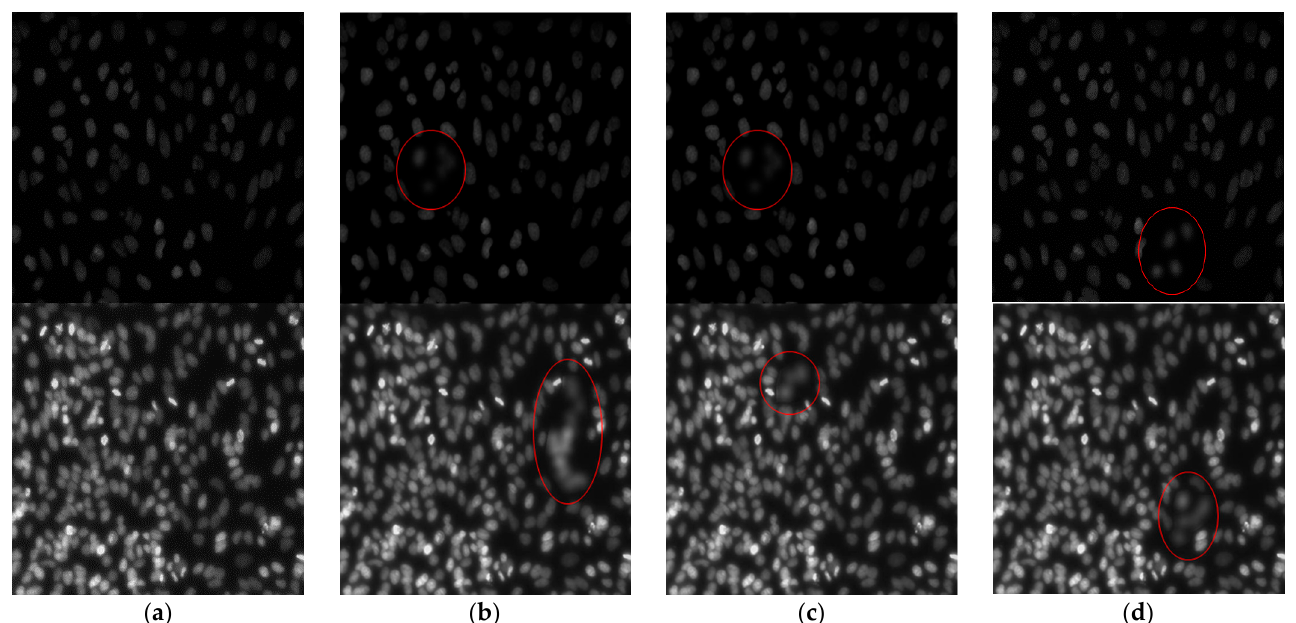
Figure 4. Grayscale image pairs for experiments with random blurring. The top row contains the “Dark cell” image set. The second row contains the “Bright cell” image set. ( a ) Original images and ( b – d ) randomly blurred images. From ( b ) to ( d ), we can see that some cells are defocused, and these are marked with a red circle.